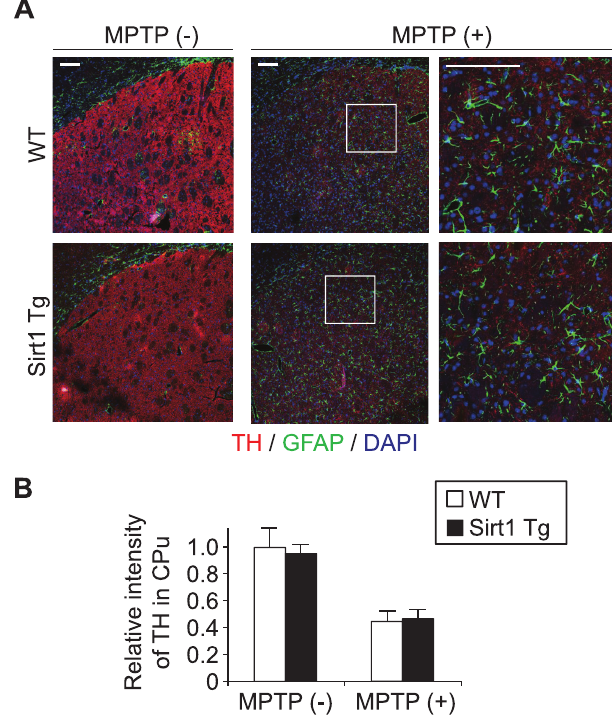
Figure 2. SIRT1 overexpression does not alleviate MPTP- induced loss of striatal DA nerve terminals and astrogliosis. ( A ) Representative immunofluorescence images of wild-type and Sirt1Tg mouse striatum/caudoputamen 4 days after intraperitoneal injection of saline with or without MPTP. Coronal sections triply labeled for tyrosine hydroxylase (TH), glial fibrillary acidic protein (GFAP), and nuclear DNA (DAPI) exhibited no recognizable histopathological differences in the loss of TH-positive cells (presumed axons and axon terminals of DA neurons) and in the proliferation of GFAP-positive astrocytes. Scale bars, 100 μm. ( B ) The relative immunofluorescence intensity for TH in the striatum was comparable between WT and Tg littermates. The bars denote mean ± standard error of the mean (n = 4 ×